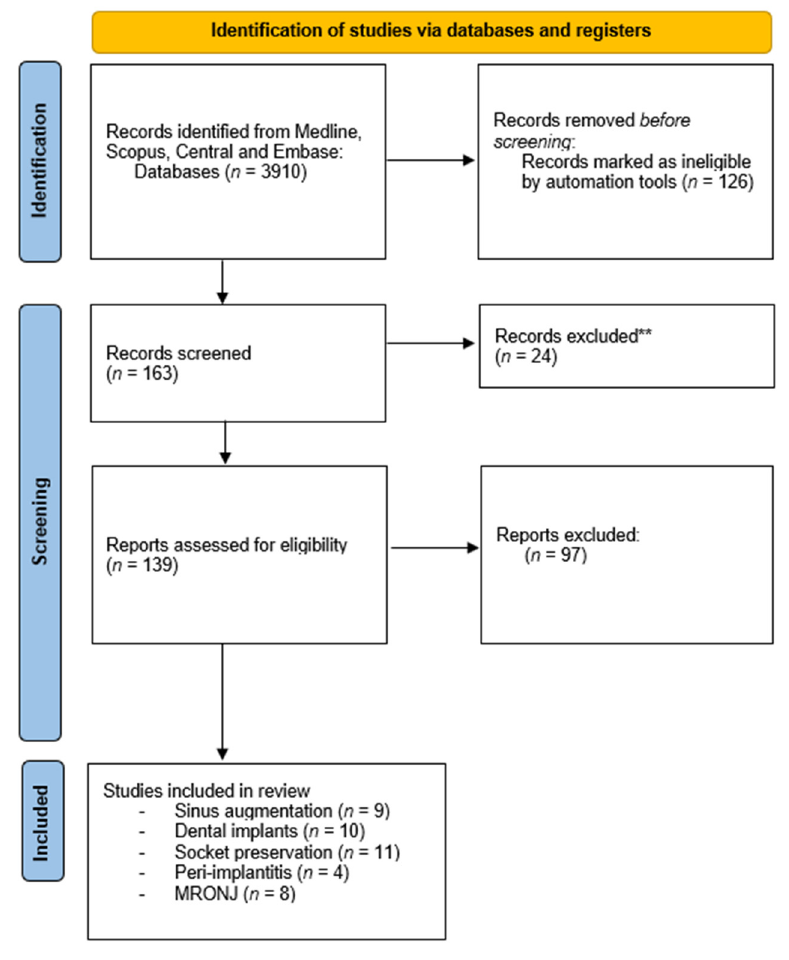
Figure 1. Flowchart of the search strategy .